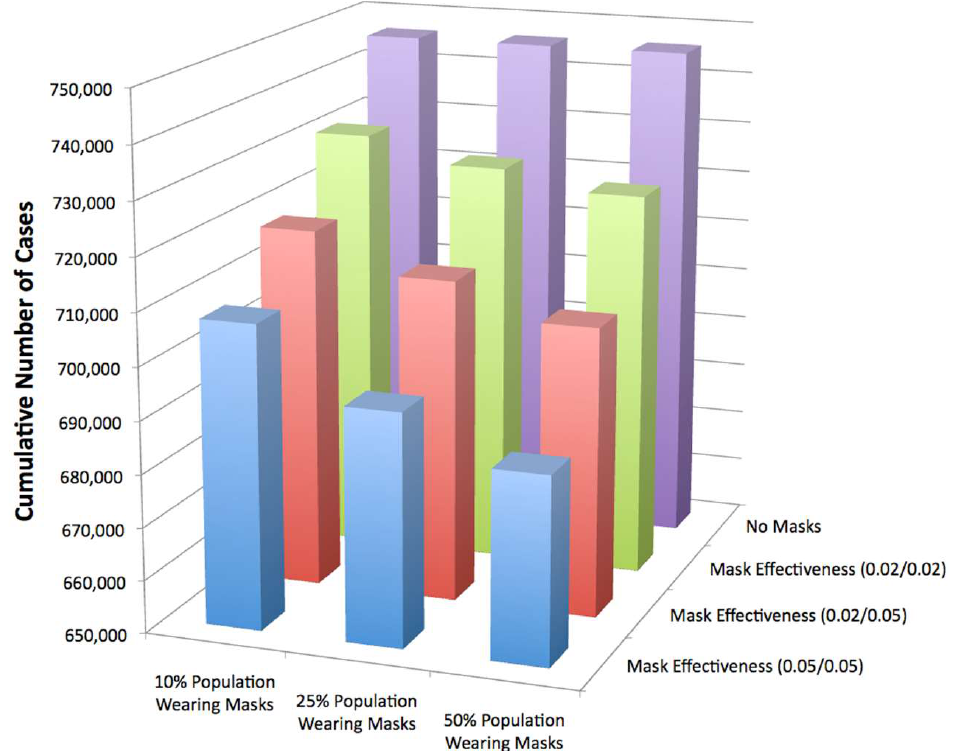
Figure 7. Cumulative number of cases for surgical masks. Reused under the terms of the Creative Commons Attribution License, crediting [72], PLoS 2010©.